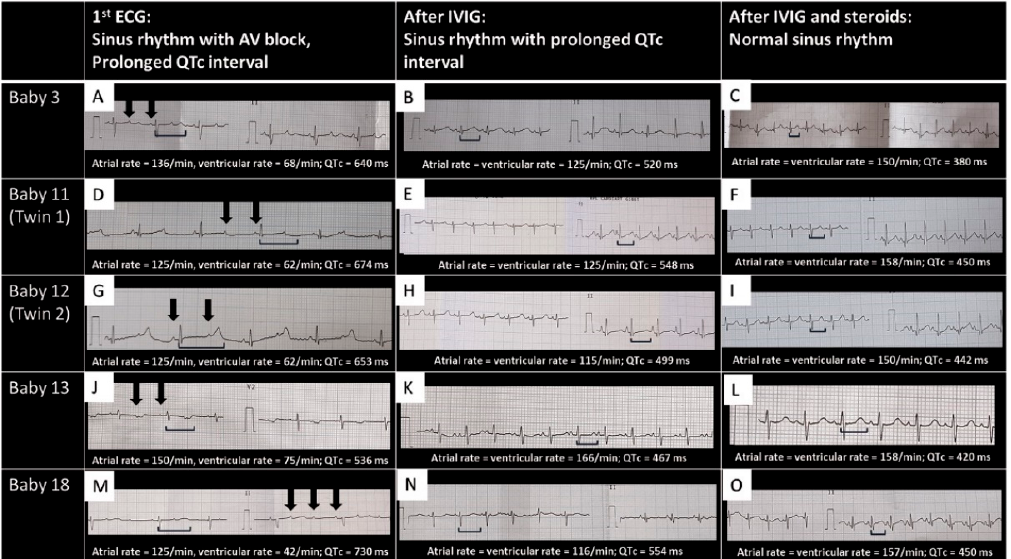
Figure 2. Representative EKGs of neonates presenting with bradycardia. Baby number sequence is the same as in Table 3. The first column showing EKGs at presentation ( A , D , G , J , M ), with sinus rhythm, prolonged QT interval and atrio-ventricular block. Middle column showing sinus rhythm and prolonged QT interval ( B , E , H , K , N ). The last column showing sinus rhythm with normal QT interval ( C , F , I , L , O ). Black arrows = atrial beats; horizontal square bracket = QT interval; QTc = corrected QT interval; ms = milliseconds. QTc values in the figure are derived by the formula QTc = QT/ √ RR.